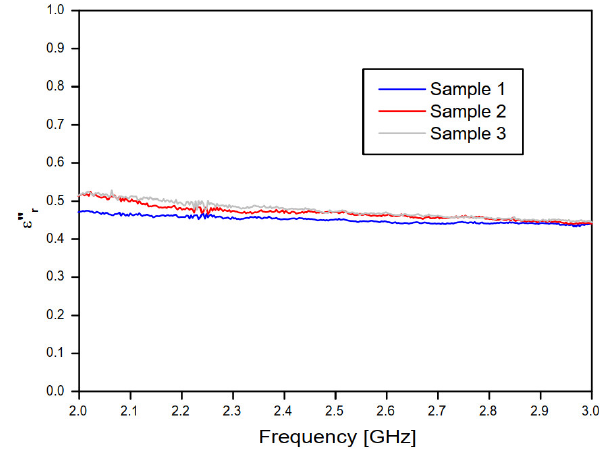
Figure 10. Real part of the relative permittivity of the three concrete samples, according to the NRW method and the complex transmission coefficient (S21) measured results.